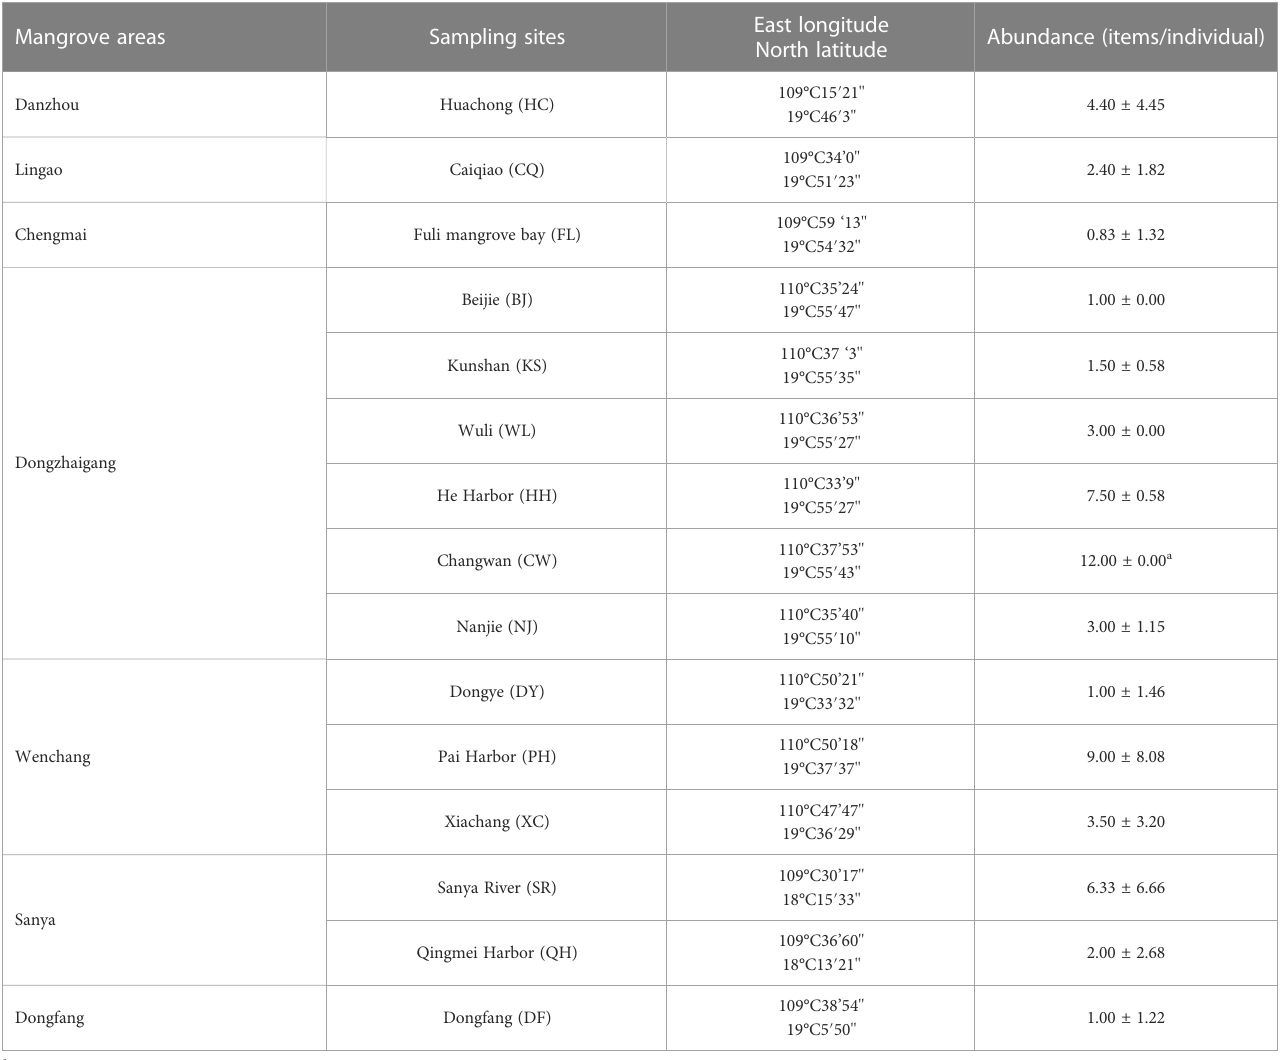
TABLE 2 Abundance of microplastics in benthos samples from different sample